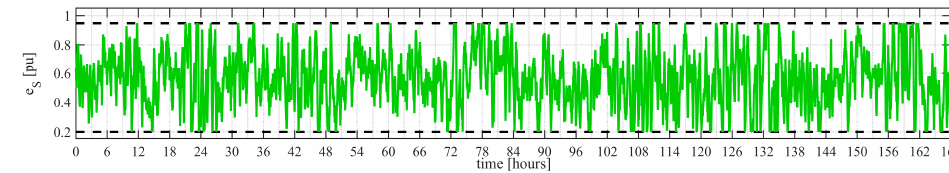
Figure 18. Residual and grid power profiles achieved by FBM over a generic week by employing different time horizons. Figure 19. The B power profiles achieved by FBM over a generic week by employing different time horizons. Figure 20. The B energy evolutions achieved by FBM over a generic week by employing different time horizons. Figure 21. Power fluctuations and forecasting errors on residual power ( δ r , light purple) and grid power ( δ g , blue) by employing the proposed FBM over a generic week at T = 24 h, together with the S power demand ( Δ S , magenta).